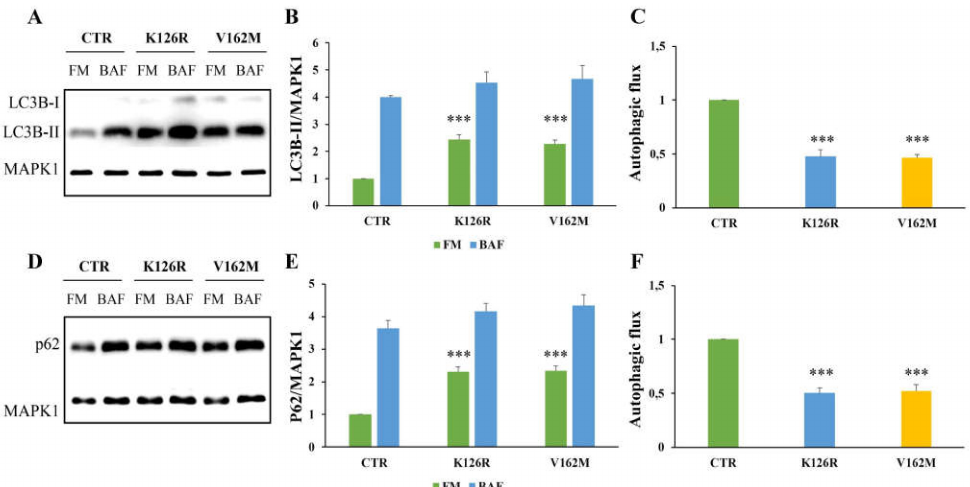
Figure 1. Analysis of autophagy in CMT2B fibroblasts by Western blotting. Control fibroblasts (CTR) and cells carrying K126R and V162M mutations were incubated with full medium (FM) and with 400 nM of Bafilomycin A 1 (BAF) for 3 h. ( A , D ) Western blotting analysis was performed on cellular lysates from healthy control fibroblasts and fibroblasts carrying RAB7 K126R and RAB7V 162M mutations using specific antibodies against LC3B and p62. MAPK1 was used as loading control. Densitometric analysis of immunoblot shown in ( B ) and ( E ) was performed using Image Lab software (BIO-RAD). The autophagic flux was calculated as the ratio of normalized LC3B-II ( C ) and p62 ( F ) between BAF and FM of the same sample. Values are the mean ± standard error (SE) of three different and independent experiments. *** p <